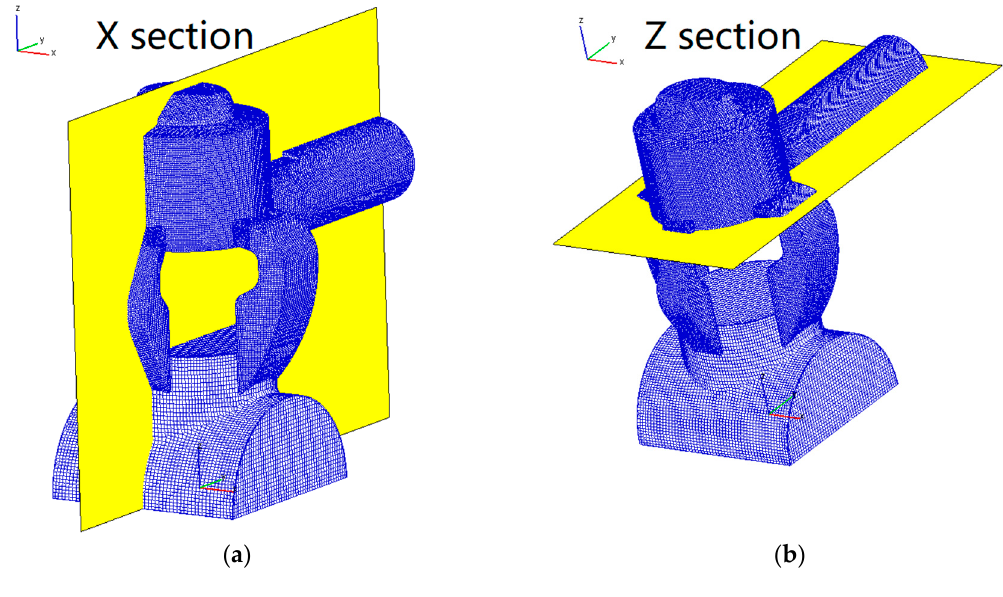
Figure 18. ( a ) X section; ( b ) Z section.